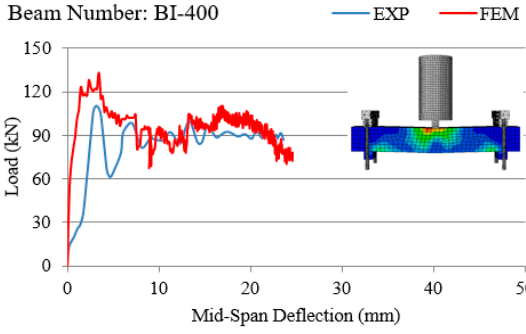
Figure 6. Load vs. mid-span deflection for BS; EXP: experimental; FEM: finite element modeling.